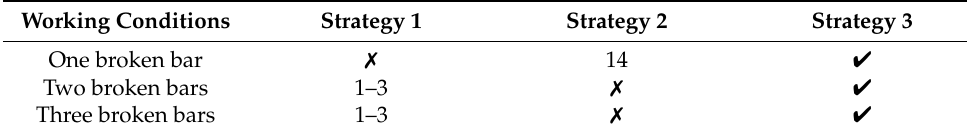
Table 6. Optimal choice of three equipment replacement strategies.